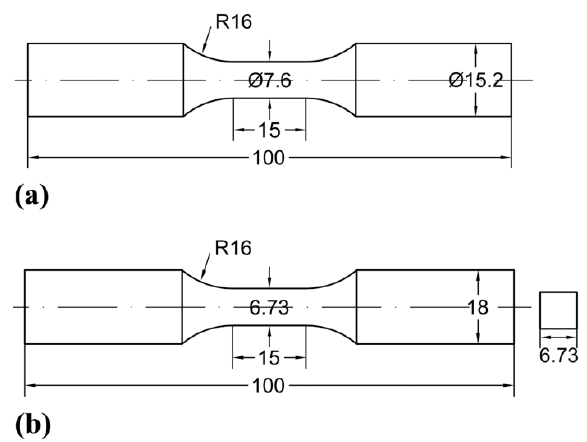
Figure 2. ( a ) Specimen with circular cross section (in mm) for conventional fatigue test and dwell fatigue test; ( b ) specimen with square cross section (in mm) for dwell fatigue test.